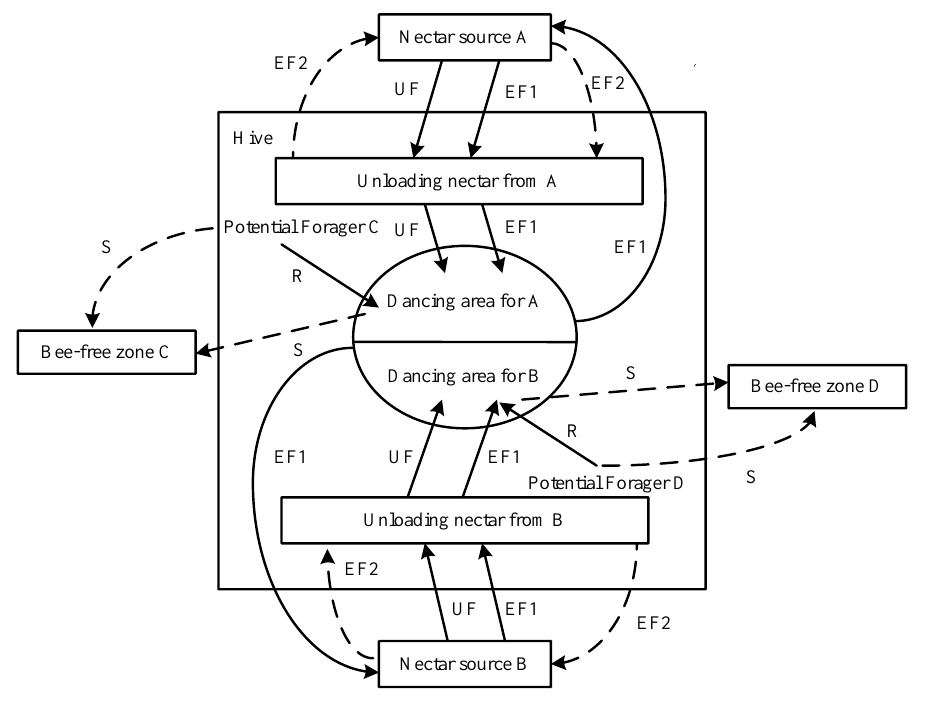
Figure 8. Nectar-collecting behavior of bees.